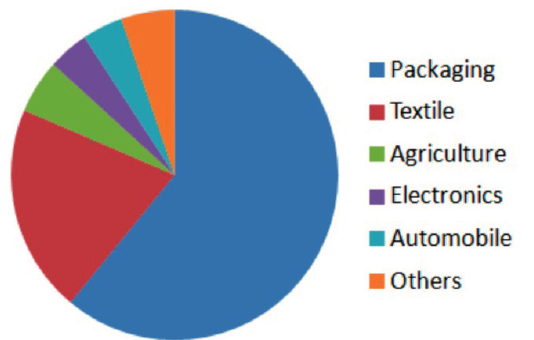
Figure 7. Polylactide market size in 2013 by application